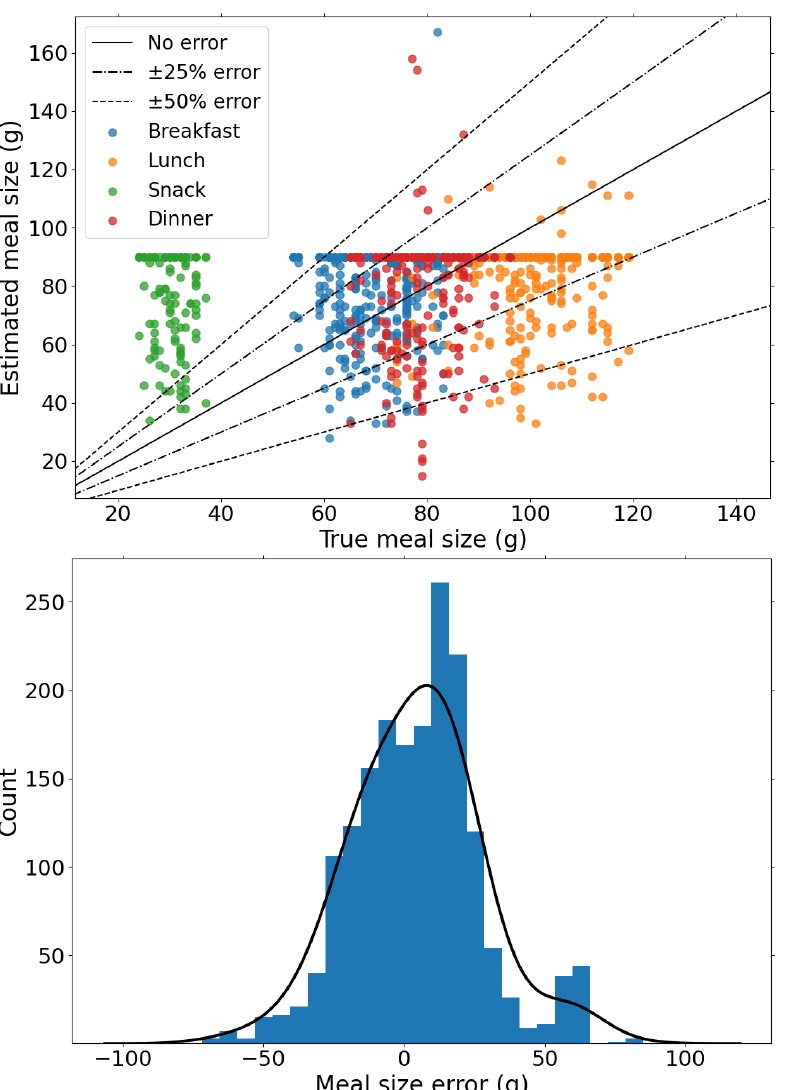
Figure 4. ( Top ) Estimated meal size versus true meal size for detected meals to determine the accuracy of meal size error. ( Bottom ) The distribution of estimated meal sizes and true meal sizes. The probability densities of meal and snack size errors is also